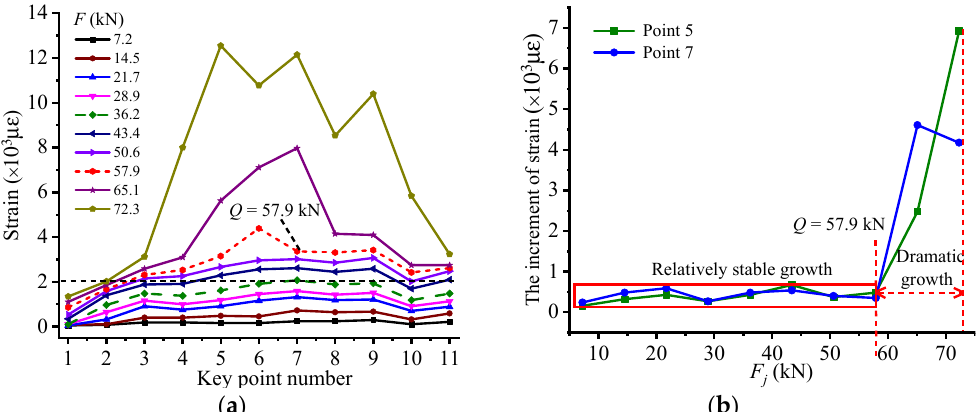
Figure 7. The changing features of strain-based stressing state mode: ( a ) the strain distribution pattern of CFRP bonded on the bottom surface of HG-1-12; ( b ) the increment of strain at measuring points 5 and 7.